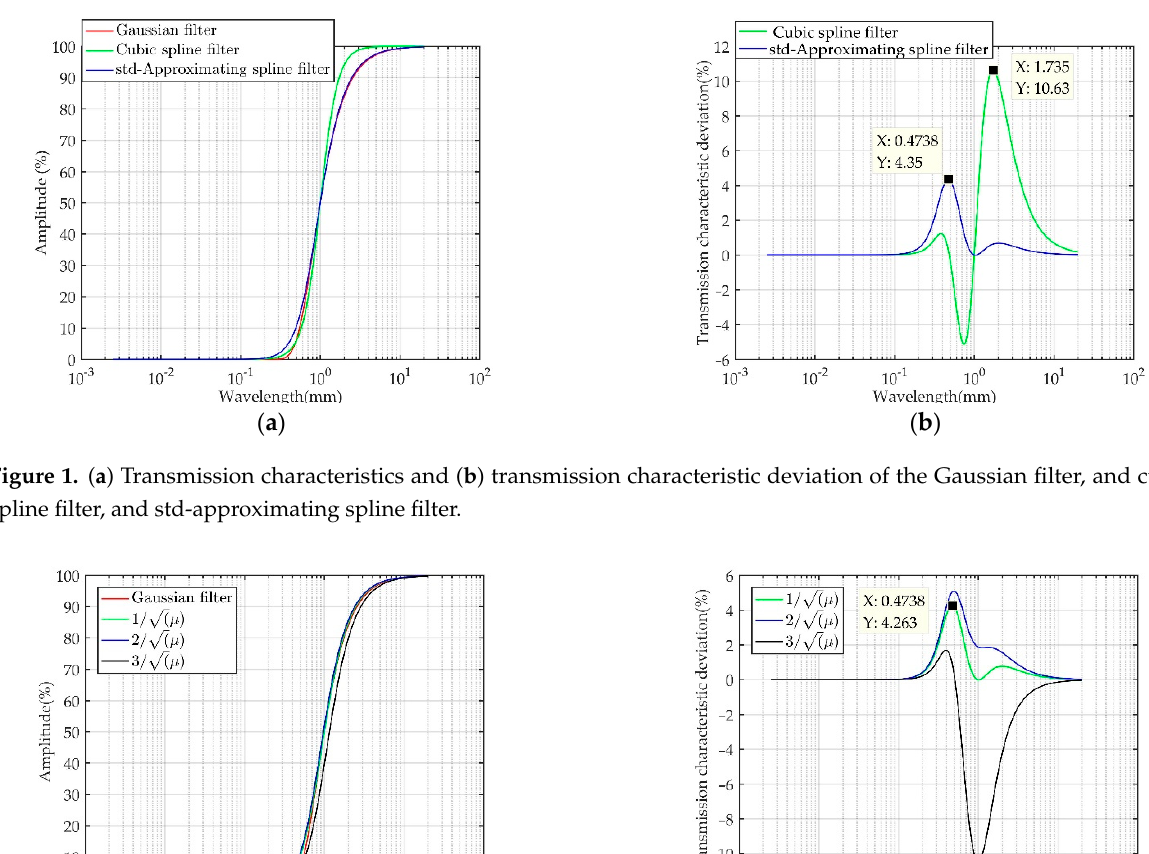
( b ) Figure 3. ( a ) Transmission characteristic and ( b ) transmission characteristic deviation of Gaussian Figure 1 and std-ap- proximating spline filter (cid:4666)(cid:2010) = 0.62524 (cid:4667) . In order to obtain higher approximation accuracy, many approximating spline filter are connected in series. The transmission characteristic of the cascade approximating spline filter can be expressed as ( ) (2) where n denotes the cascade order. The transmission characteristic deviation for different cascade orders is presented in Figure 4, where it can be seen that with the increase in the cascade order, the approximation degree also increases. However, the improvement in the approximation accuracy results in higher calculation cost. Therefore, considering the effectiveness, the cascade order should be controlled in a reasonable range. The deviation is less than 1.0% when n = 2, so it is enough to use the second-order joint approximating spline filter in practice.